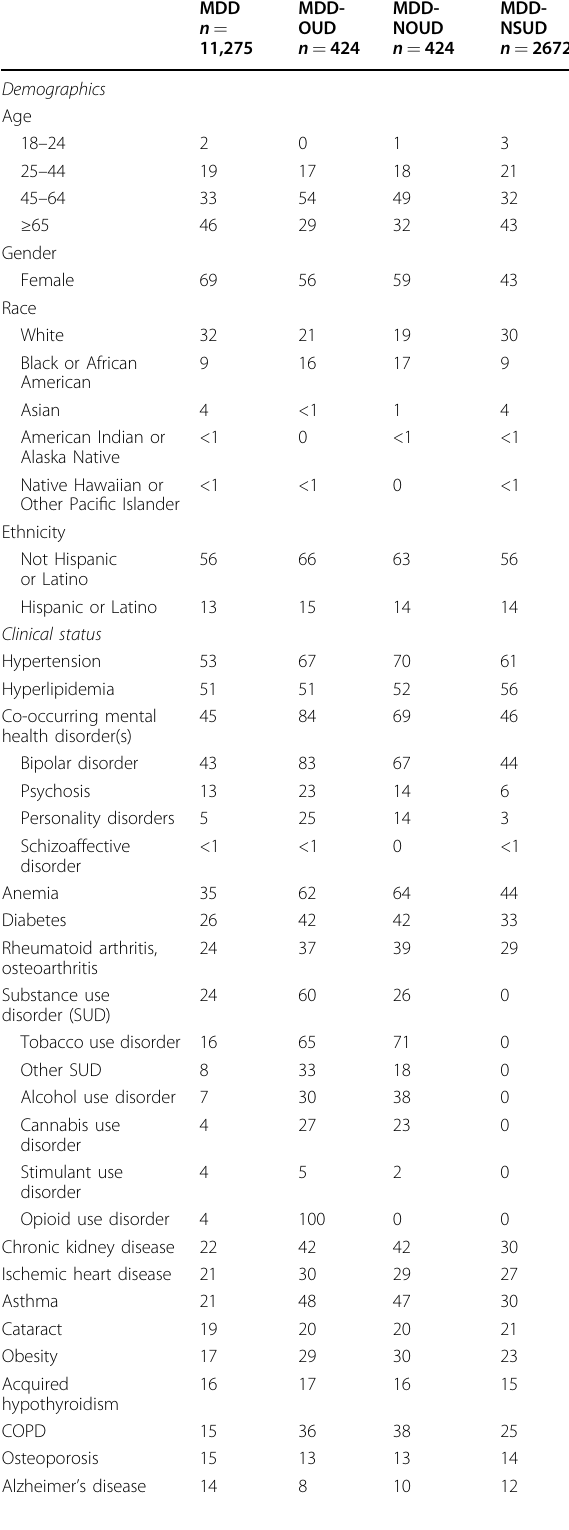
Table 1 Demographic and clinical characteristics (%) of the 11,275 patients included in this